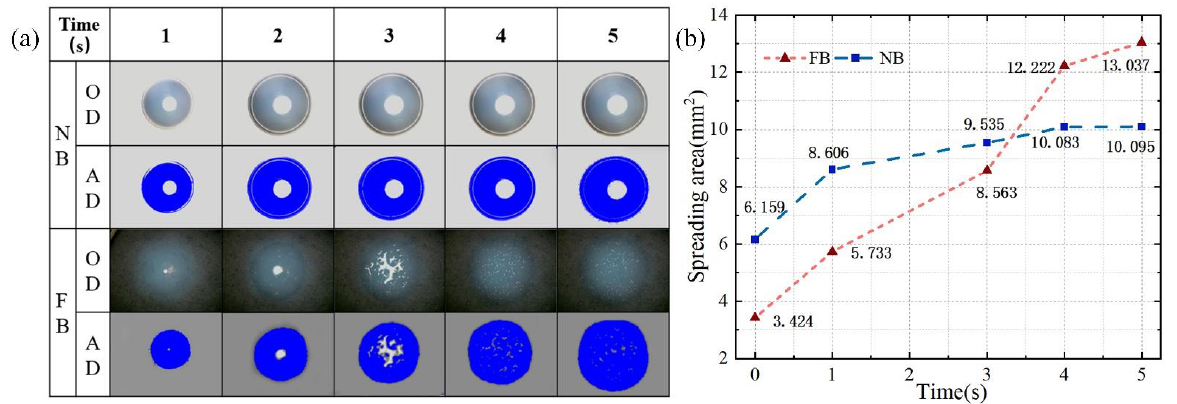
Figure 8. ( a ) Spreading experiment of an oil droplet on the tool surface; ( b ) Comparison of the spreading of an oil droplet on the tool surface of the FB and the NB. As shown in Figure 9a, the FB broach changes the contact area between the rake face and the chip and reduces the friction coefficient in the broaching process. More im- portantly, because the FB broach has good lipophilicity, it effectively ensures the lubricity and capacity of microchips removal (CMR) compared to NB, and thus reduces the F c and F t .